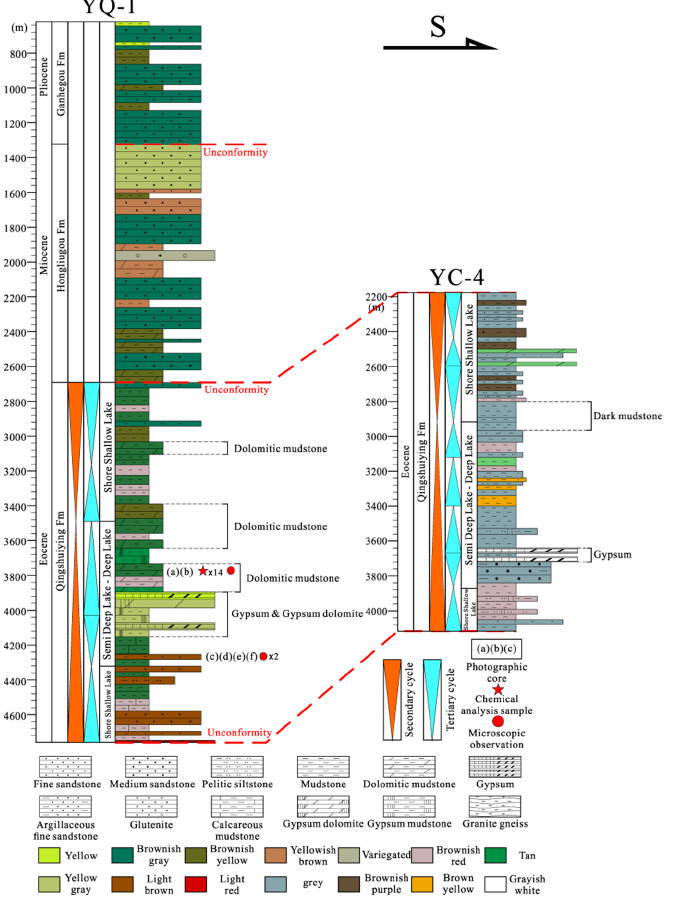
Figure 2. Logging interpretation of Well YQ-1 and Well YC-4 (see YQ-1 and YC-4 in Figure 1 for location) (Adapted from